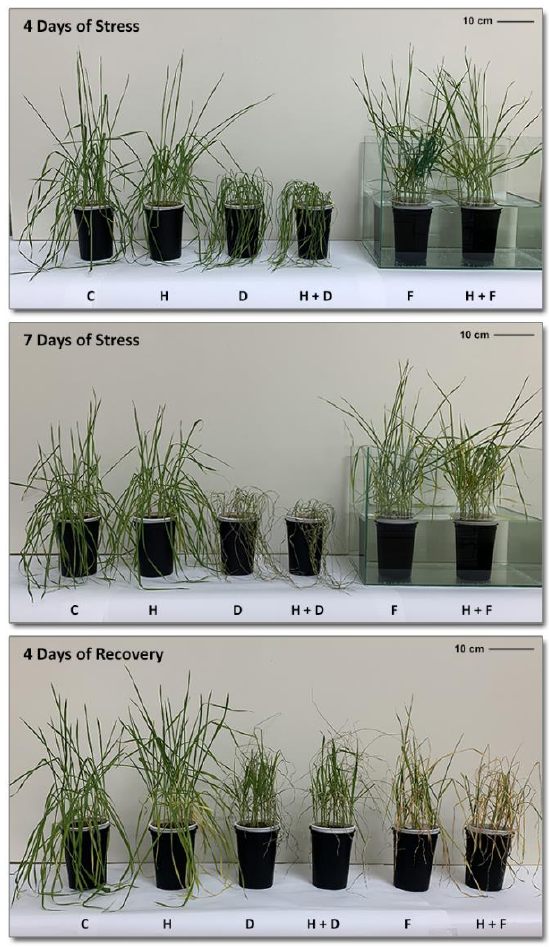
Figure 1. Phenotypic alterations of wheat plants treated with herbicide and subjected to drought or flooding stress. C — control; H — herbicide; D — drought; H + D — herbicide + drought; F — flooding; H + F — herbicide + flooding.